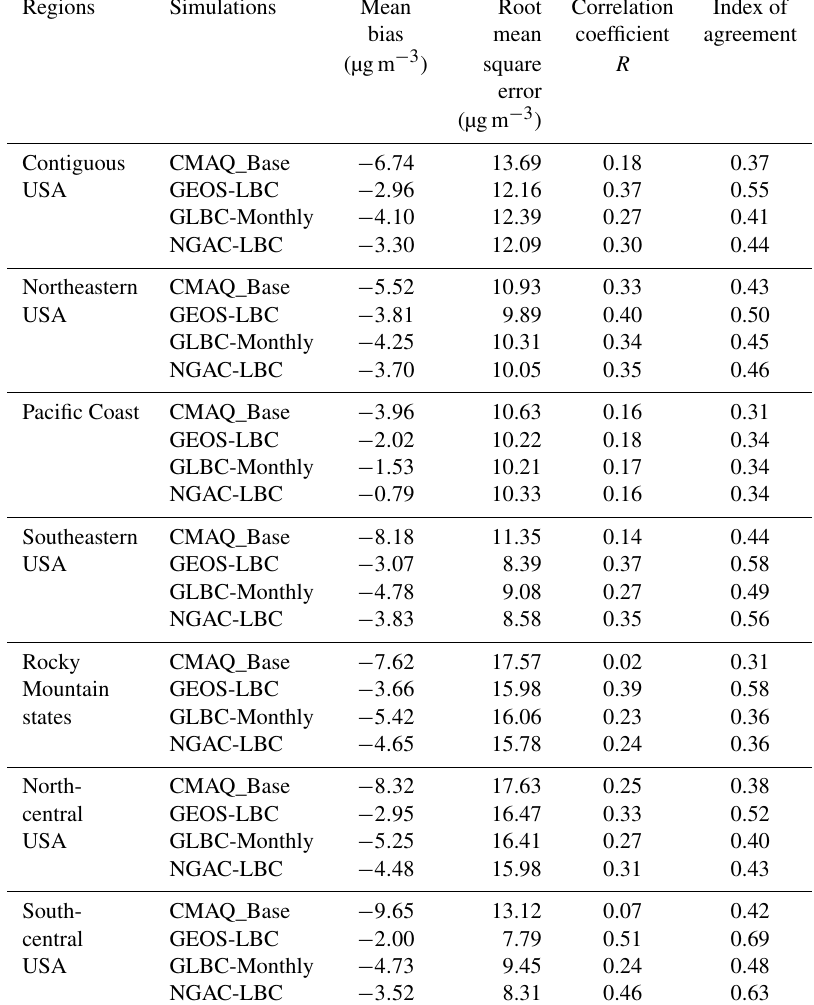
Table 4. Regional PM 2 . 5 statistics of the four simulations (CMAQ_Base, GEOS-LBC, GLBC-Monthly, and NGAC-LBC) from 24 June to 8 July